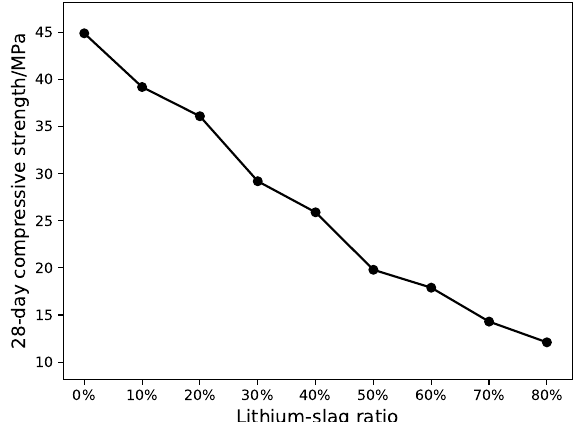
Figure 3. 28-day compressive strength of lithium-slag cement mortar.